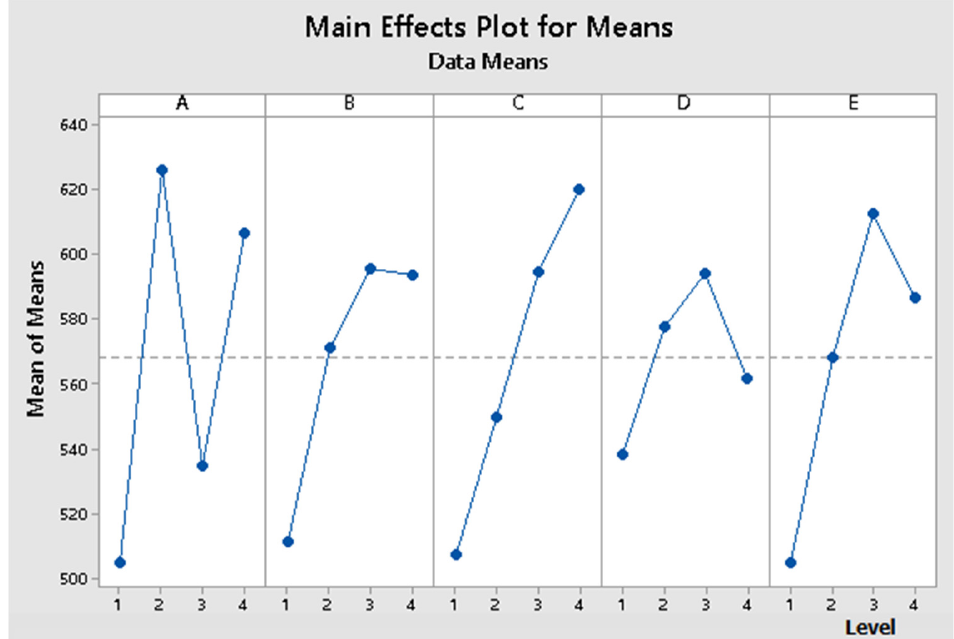
Figure 7. The values obtained for the main effects plot for means.